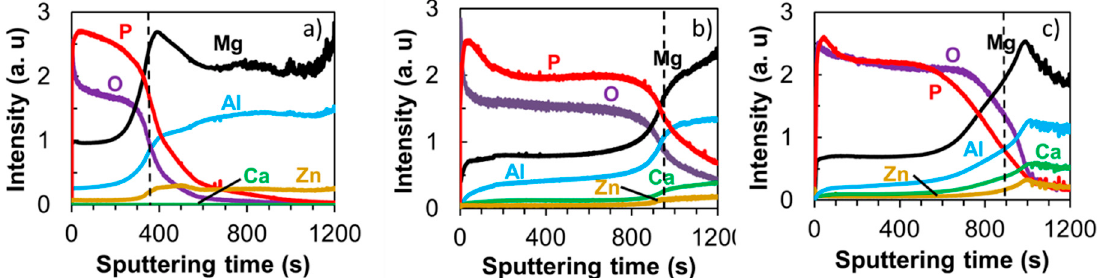
Figure 5. Glow-discharge optical emission spectroscopy (GDOES) elemental depth profiles of PEO coatings on ( a ) AZ61, ( b ) AZX611, and ( c ) AZX612 specimens after anodization in 0.5 mol.dm − 3 Na 3 PO 4 solution at 25 °C for 20 min. The dashed lines indicate the oxide–metal interface.